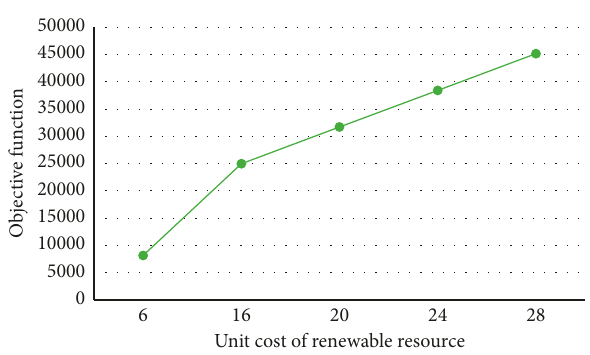
Figure 5: Amount of change in the objective function with an increasing unit cost of the renewable resource.